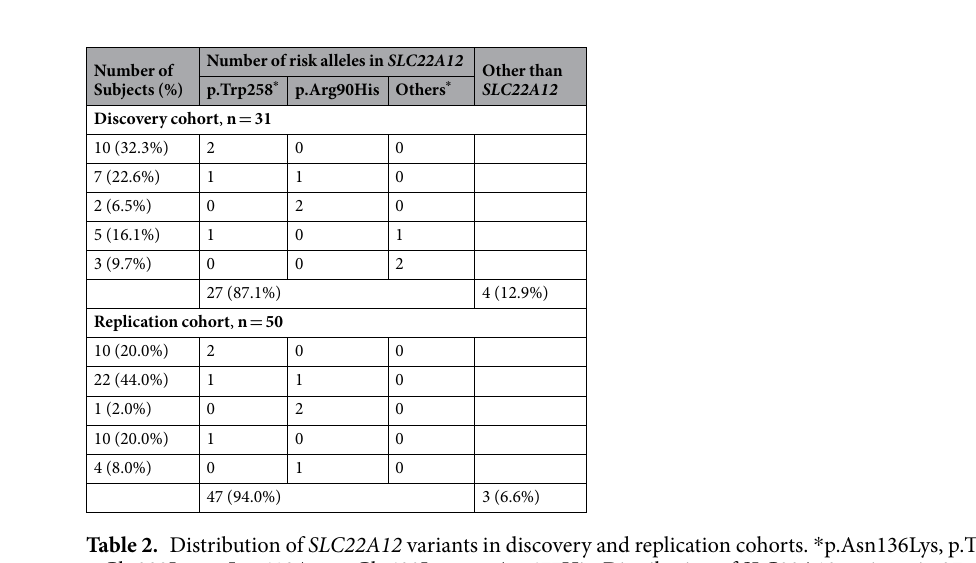
Number of Subjects (%)